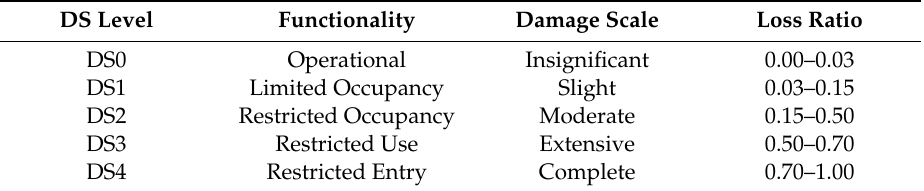
Table 1. Anticipated functionality level for each damage state along with their damage scale and damage ratio as a percentage of the total building replacement